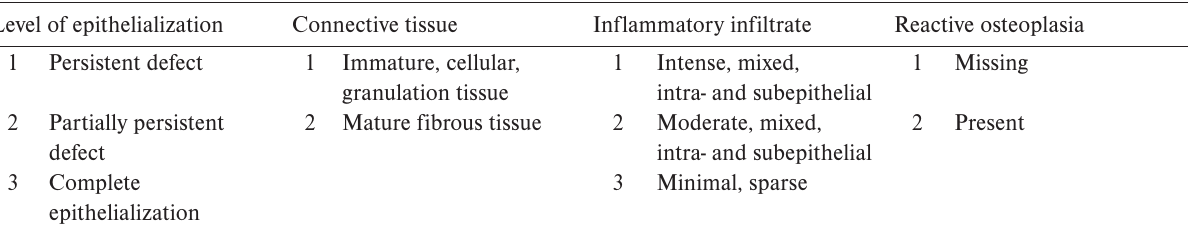
Scheme used for semi-quantitative evaluation of the level of epithelialization, quality of connective tissue, and presence of inflammatory infiltrates and reactive